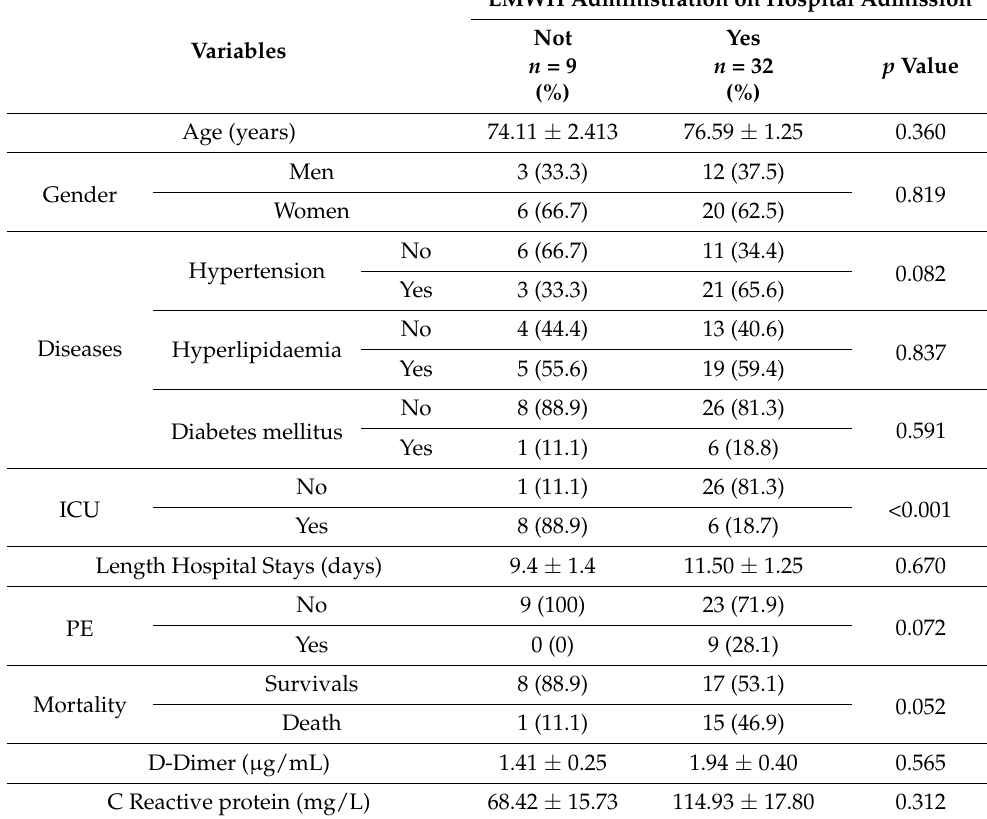
Table 2. Effect of LMWH treatment on hospital admission in geriatric COVID-19-infected patients taken daily Aspirin (100